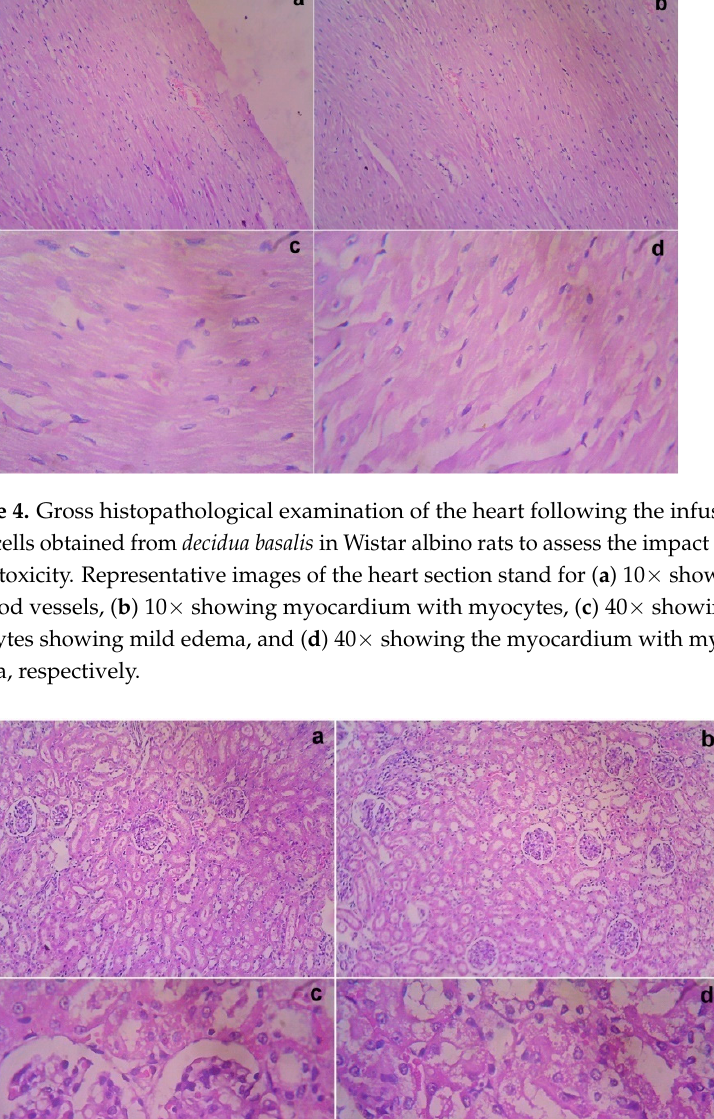
Figure 3. Gross histopathological examination of the lung following the infusion of mesenchymal stem cells obtained from decidua basalis in Wistar albino rats to assess the impact of safety, efficacy, and acute toxicity. Representative images of the lung section stand for ( a ) 10× showing alveoli dila- tation, ( b ) 10× showing normal bronchi and peribronchiole, ( c ) 40× showing mild dilatation of alve- oli, and ( d ) 40× showing destructed architecture, respectively.